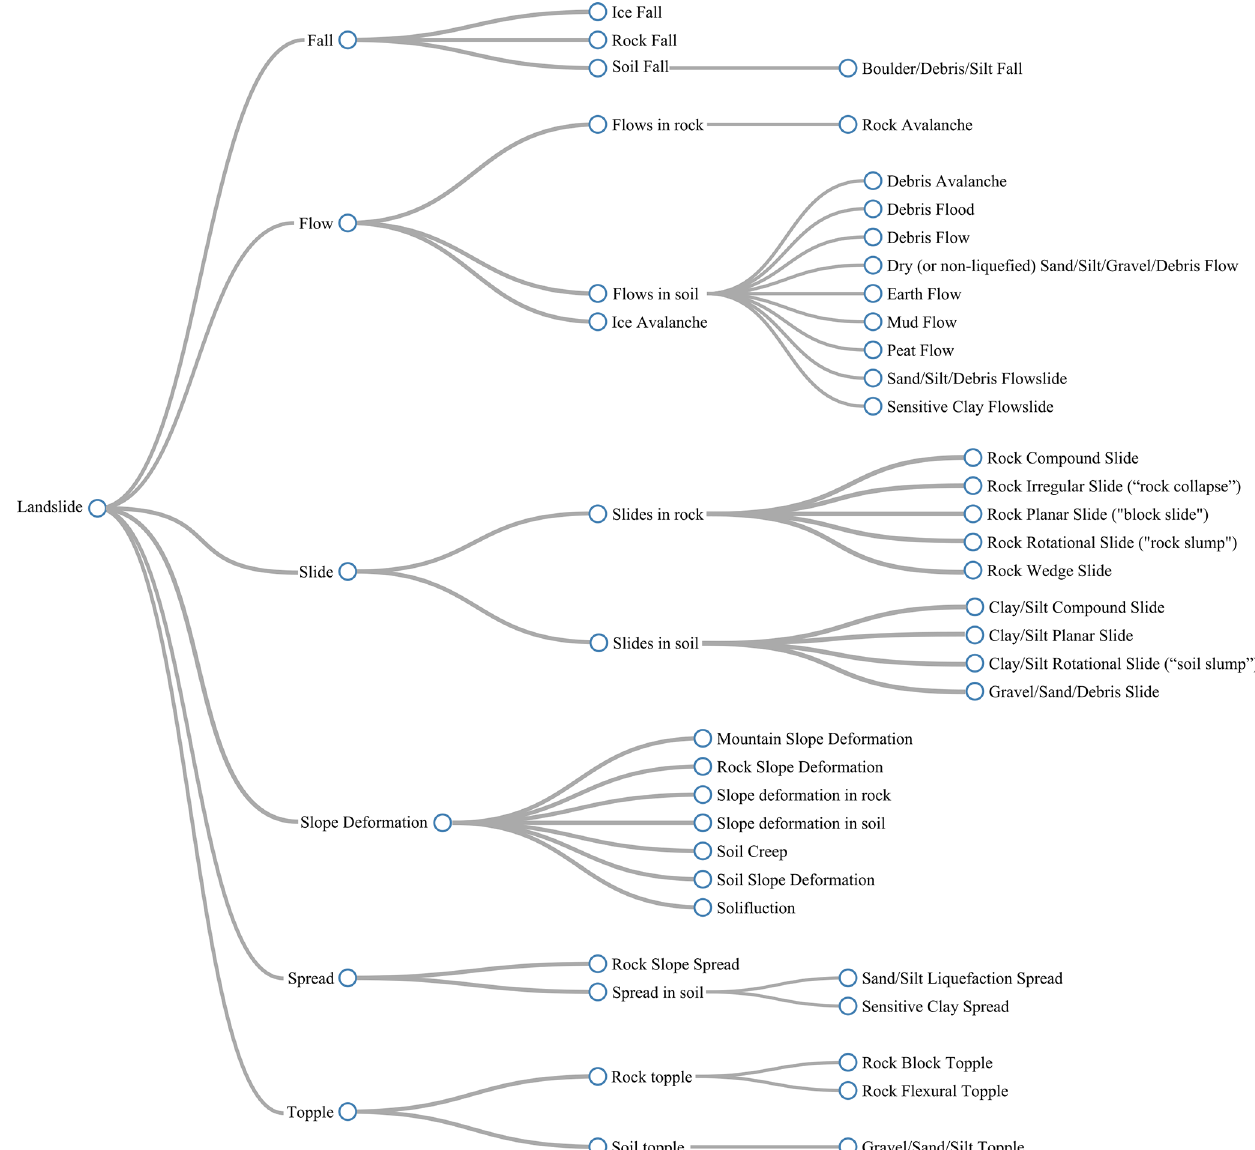
Figure 3. Natural Hazard category code list extension for